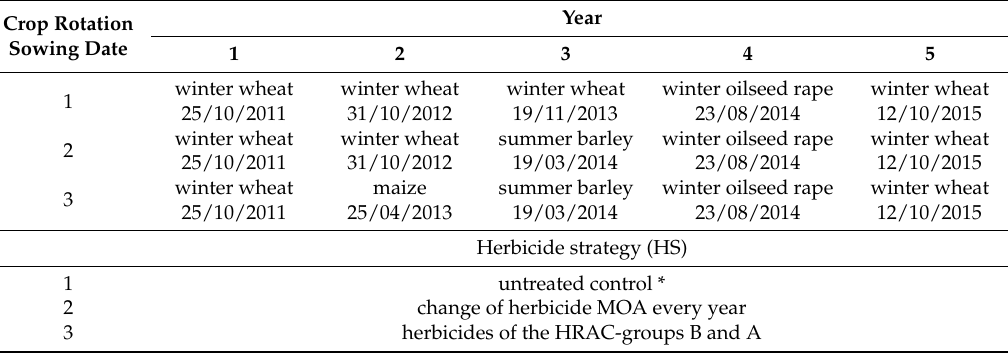
Table 1. Crop rotations (CR), sowing dates and herbicide strategies (HS) of the experiment. Crop Rotation Sowing